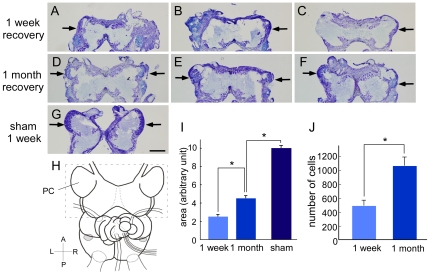
The size and number of cells in the PC is larger in the 1 month recovery group than in the 1 week recovery group.Representative photographs of toluidine blue-stained sections of brains 1 week after a PC lesion (A–C), 1 month after a PC lesion (D–F), and 1 week after a sham operation (G). Only the cerebral ganglia are shown. Arrows indicate the PC. Scale bar, 500 µm. (H) A schematic drawing of the slug brain. The rectangle surrounds the cerebral ganglia including the PC. (I) Quantification of the sum of the bilateral PC area (1 week recovery, n = 34; 1 month recovery, n = 53; sham, n = 23) showed that the area is significantly diminished one week and one month following lesion, with some recovery in the one month recovery group. (J) The number of cells within the PC is larger in the 1 month recovery group (n = 19) than in the 1 week recovery group (n = 18). *P<0.001 by Student's t-test. A, anterior; P, posterior; R, right; L, left.